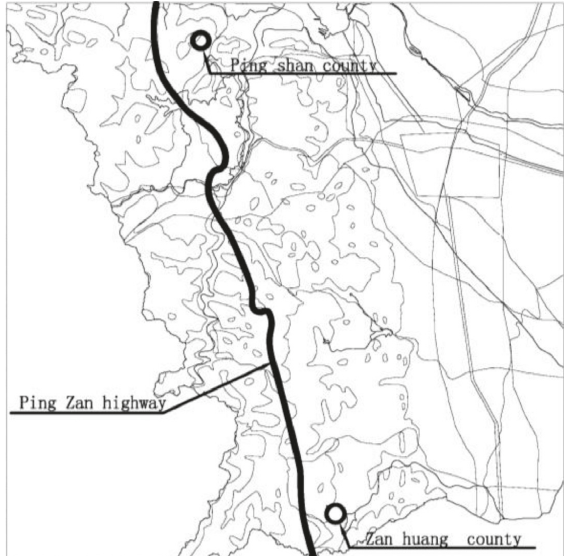
Figure 3: The relationship between tamping settlement and tamping times.